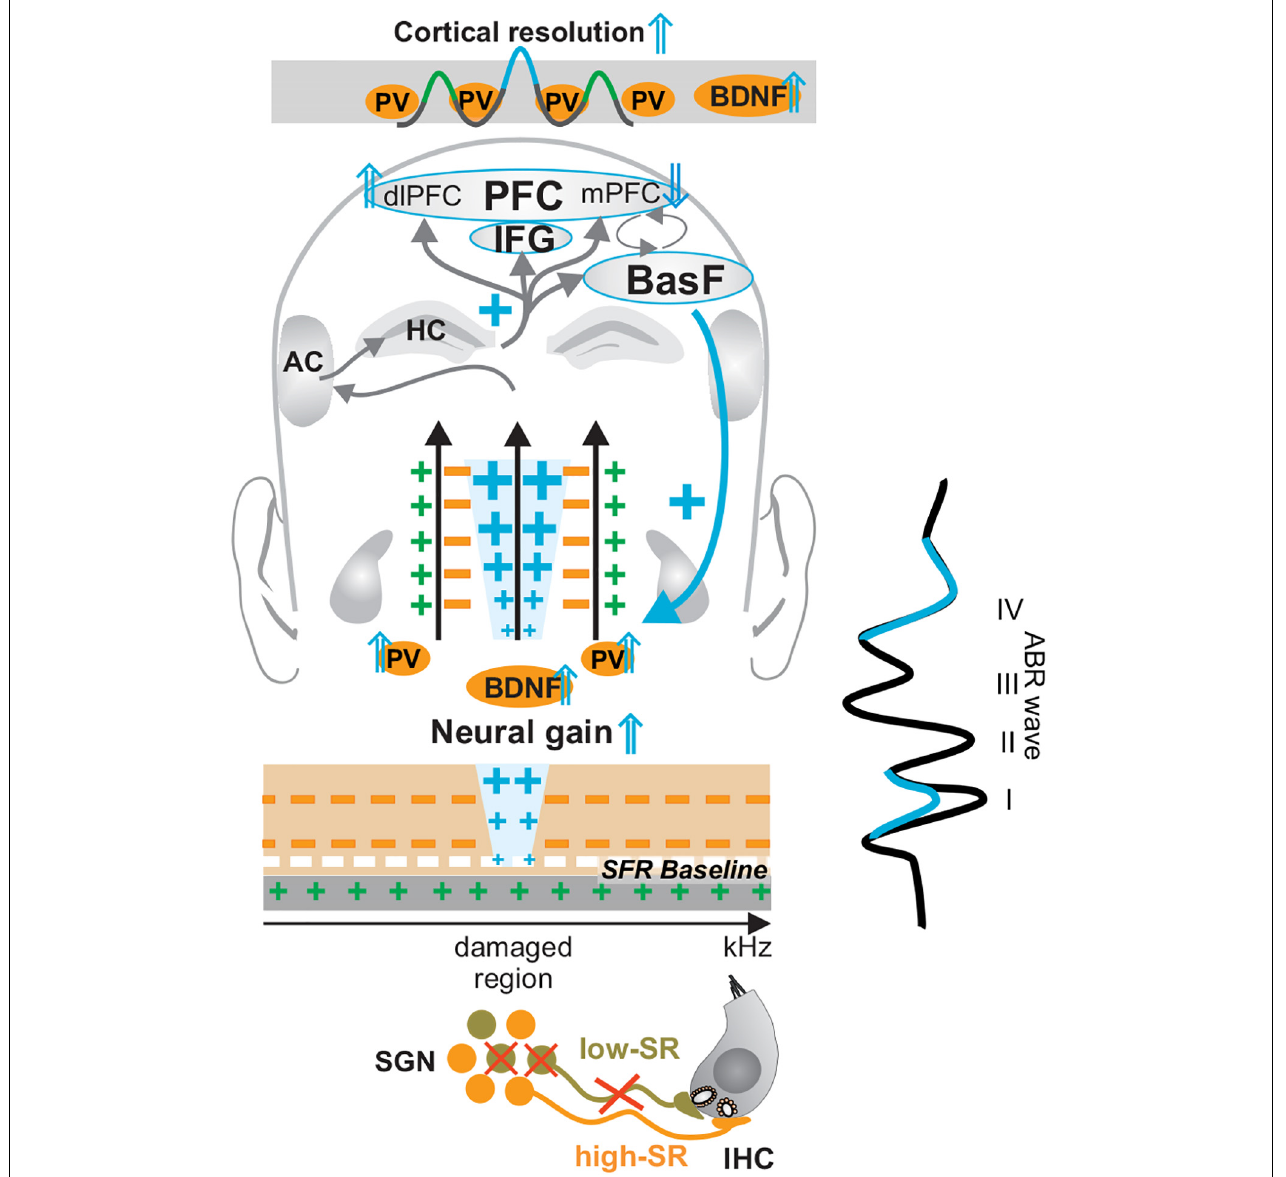
FIGURE 3 | Central neural gain mechanism following mild acoustic trauma and aging. When the numbers of low-SR auditory fibers (in light green) decline during aging or following auditory damage, a significantly enhanced output of central circuits (central compensation and enhanced blue crosses) may critically depend on the maintained activity of high-SR auditory fibers (in orange), to assure the generation of high discharge rates and central compensation of deprived auditory input (ABR wave in blue). During this process of central neural gain (blue crosses), a BDNF- and memory–dependent amplification process requires the activation of hippocampal circuits (upper blue cross), the activation of the basal forebrain (BasF), the balancing activation of dorsolateral, medial prefrontal cortex (dlPFC and mPFC) and specific PFC regions, such as the inferior frontal gyrus (IFG), to enhance auditory signals above noise levels (feedback mechanism, blue downward arrow and cross on the right side). Modified after Knipper et al. (2020). IHC, inner hair cell; SGN, spiral ganglion neuron; SFR, spontaneous firing rate; HC, hippocampus; IFG, inferior frontal gyrus; BasF, basal Forebrain; PFC, prefrontal cortex; dlPFC, dorsolateral PFC; mPFC, medial PFC; AC, auditory cortex; PV,